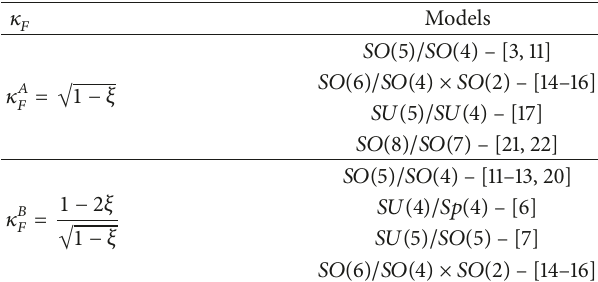
Table 1: 𝜅 퐹 in different